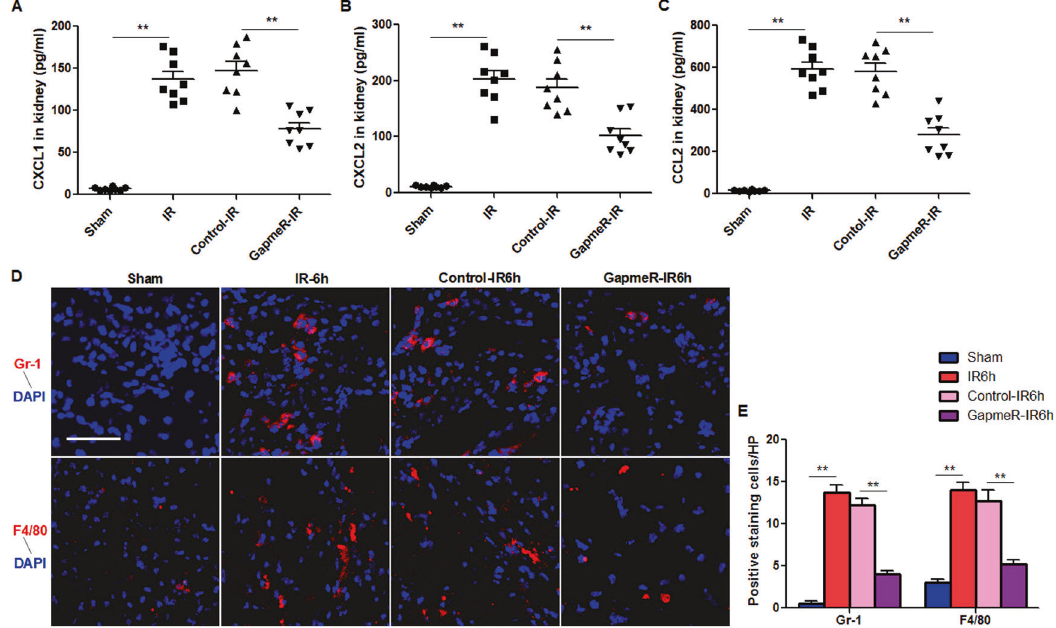
Fig. 4 Inhibition of IRAR reduces ischemia-reperfusion (IR)-induced production of chemokines and in fi ltration of immune cells. A – C ELISA of CXCL1 ( A ), CXCL2 ( B ), CCL2 ( C ) in the kidney 24 h after renal IR ( n = 6 – 8). D Immuno fl uorescence staining of Gr-1 and F4/80 in the kidney 6 h after renal IR. Gr-1 was used as a marker of neutrophils and F4/80 was used as a marker of macrophages. Scale bar, 100 μ m ( n = 6 – 8). E Quanti fi cation of Gr-1-positive neutrophils and F4/80-positive macrophages in the kidneys. Data represent mean ± SEM. n = 4. * p < 0.05, ** p <